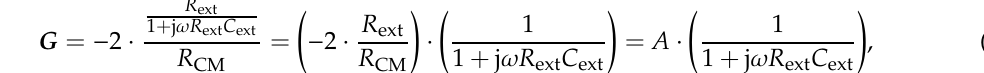
Figure 3. Block diagram of the measurement system. A red scenario stands for powering the ECG system by an AC/DC adapter where data are transferred to the PC via a USB cable. A blue scenario stands for a battery-powered ECG system where data are transferred wirelessly via Bluetooth.